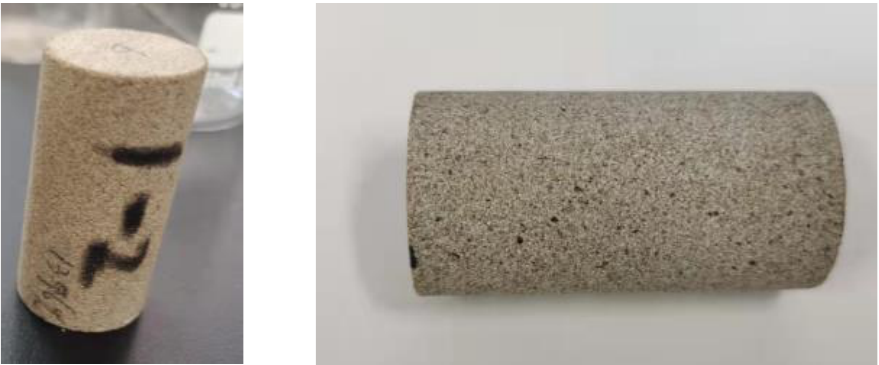
Figure 1. Core samples for imbibition experiments.